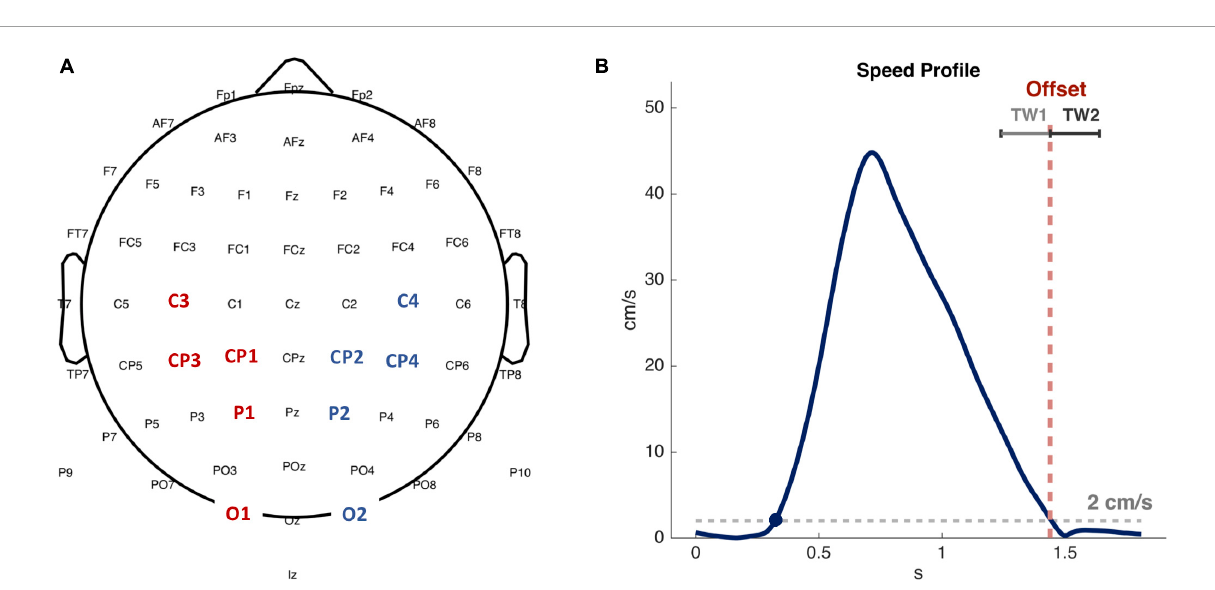
(4, 32 Hz) frequency span.